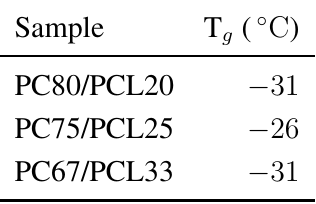
Table 7. T for the PC/PCL samples. g